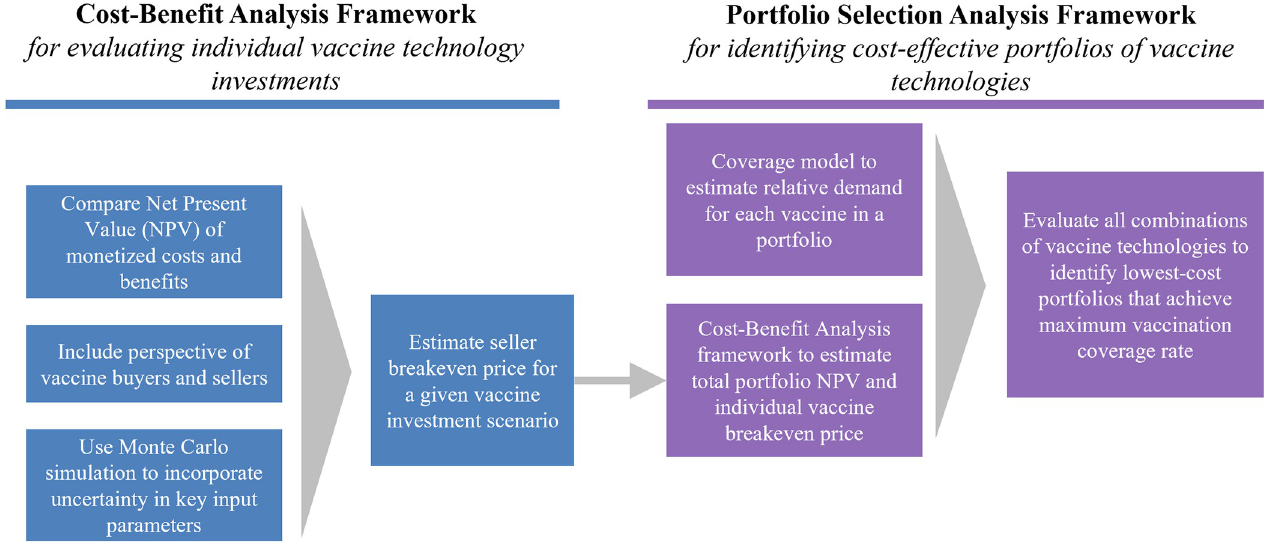
Fig 1. Conceptual overview of the model for evaluating the costs and benefits of potential vaccine investments, both individually and as a portfolio of multiple potential investments.